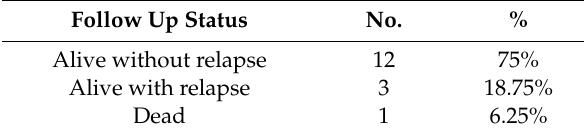
Table 2. Follow up status of the 16 studied patients treated with